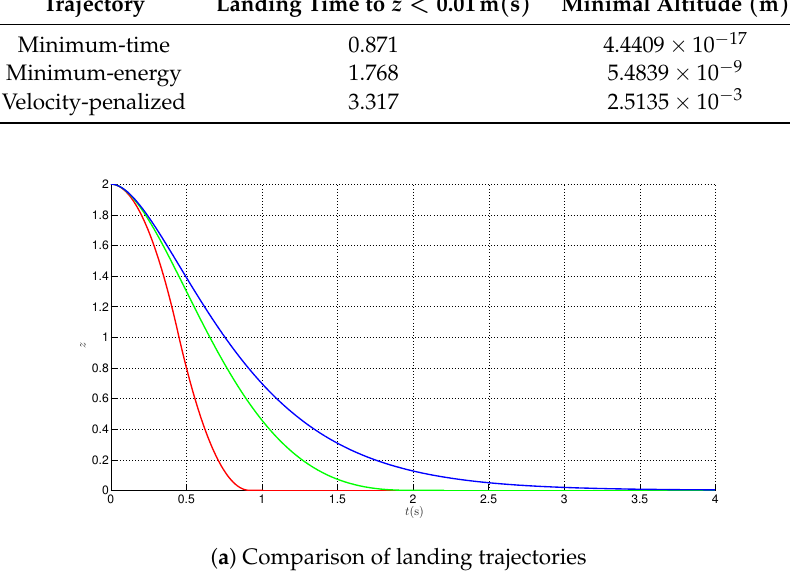
( a ) Comparison of landing trajectories Figure 8.